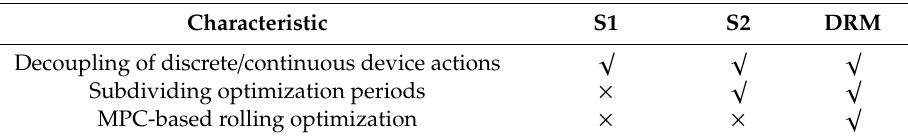
Table 3. Comparison of three voltage optimization